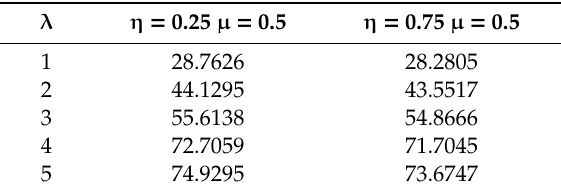
First five natural frequencies for the USFG distribution for two di ff erent states of partial